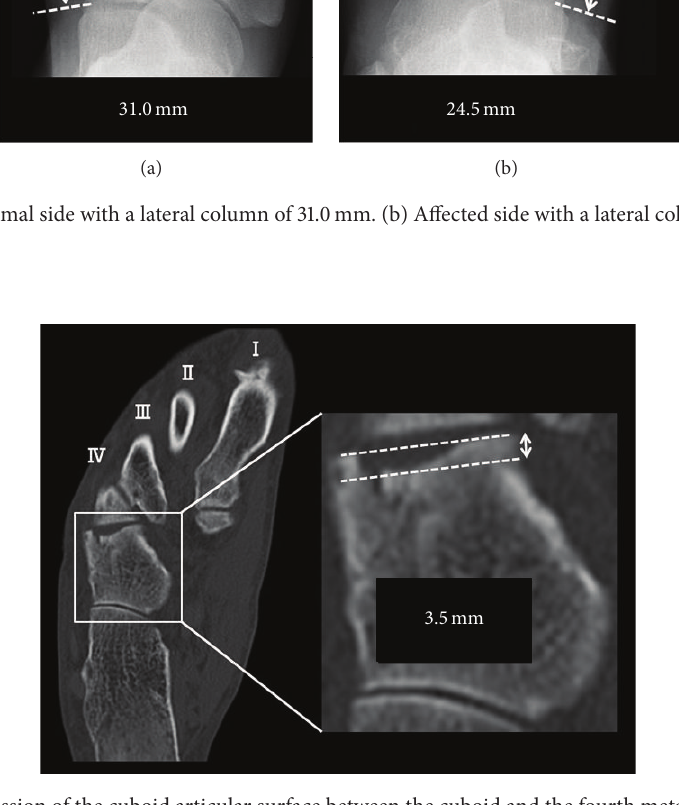
Figure 2: Depression of the cuboid articular surface between the cuboid and the fourth metatarsal (3.5